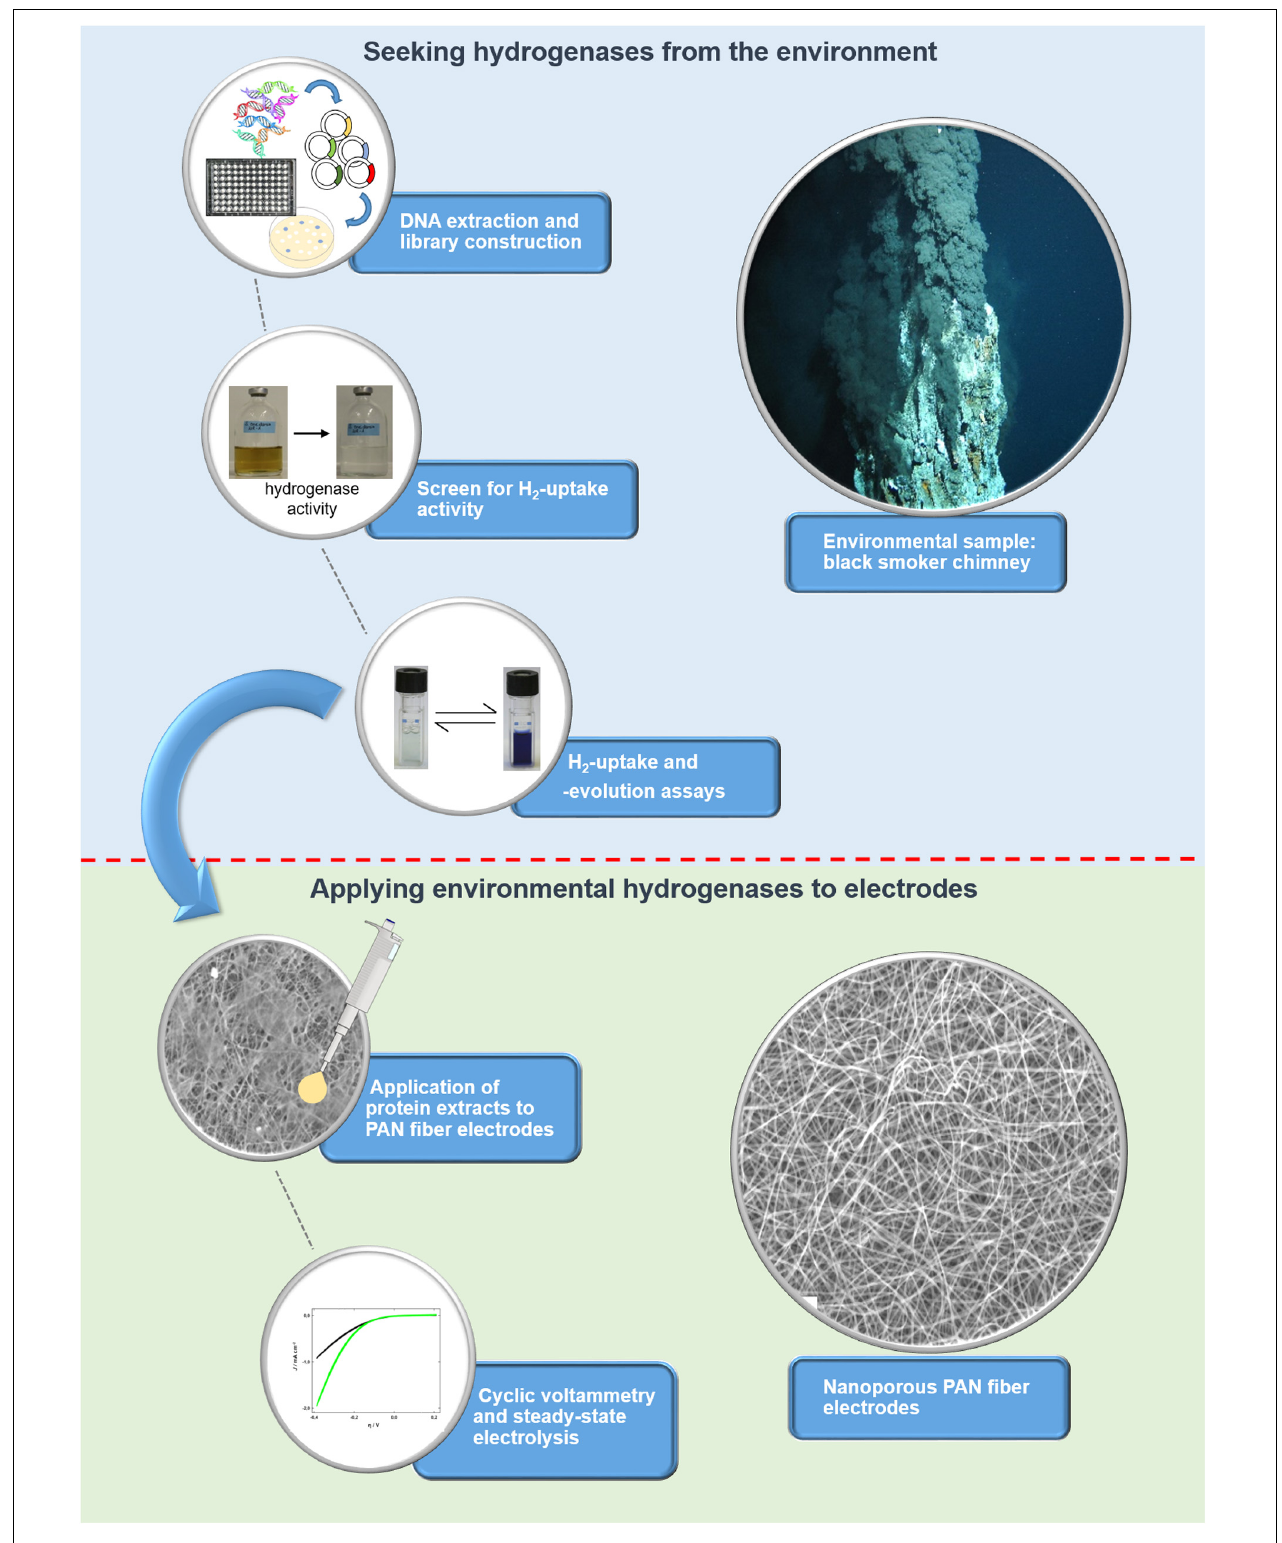
FIGURE 1 | Overview of the workflow for identifying (blue background) and applying metagenomic hydrogen converting enzymes to electrodes with large specific surface area (green background). The screen for hydrogen uptake activity is based on a color change of the medium as a result of the reduction of Fe(III)citrate, which can only take place if hydrogen is oxidized by a hydrogen converting